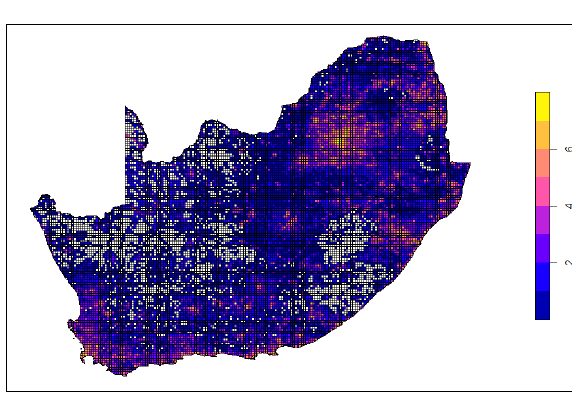
Figure 1: A coverage map of South Africa, Lesotho and eSwatini, indicating the numbers of cards per pentad. Colours are based on the log of the number of checklists for each pentad. Grey pentads have no full protocol cards. Urban and proximate areas are well covered, while Lesotho, the far Eastern Cape and Northern Cape are generally poorly